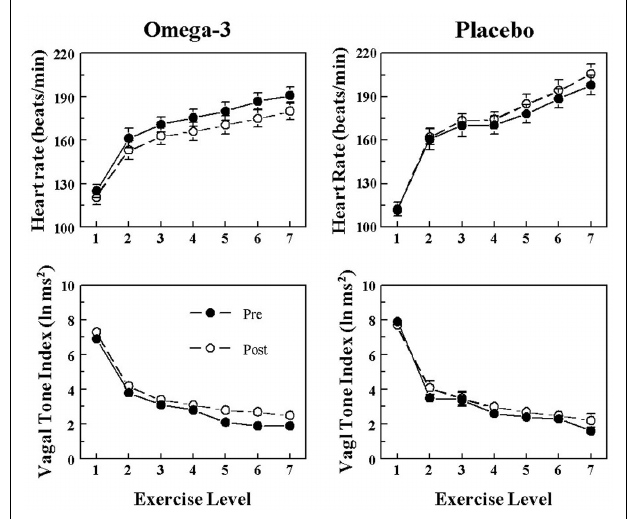
FIGURE 3 | Effect of omega-3 polyunsaturated fatty acids (n − 3 PUFAs) on the heart rate and heart rate variability response to